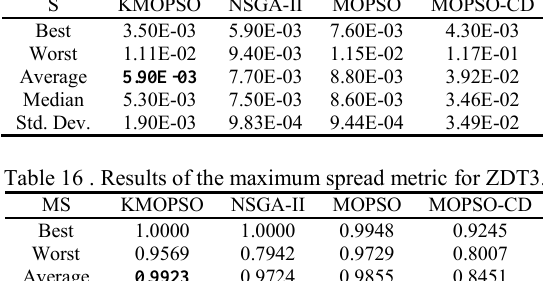
Table 15 . Results of the spacing metric for ZDT3.